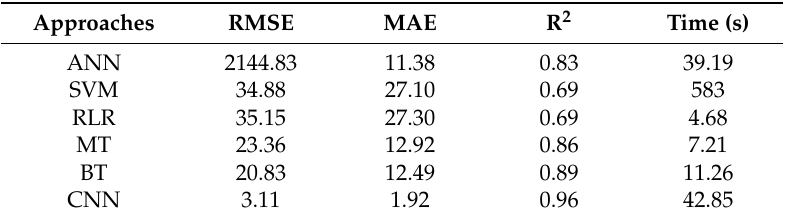
Table 3. The performance of CNN compared with different supervised modelling approaches (28 × 28 dimension size).